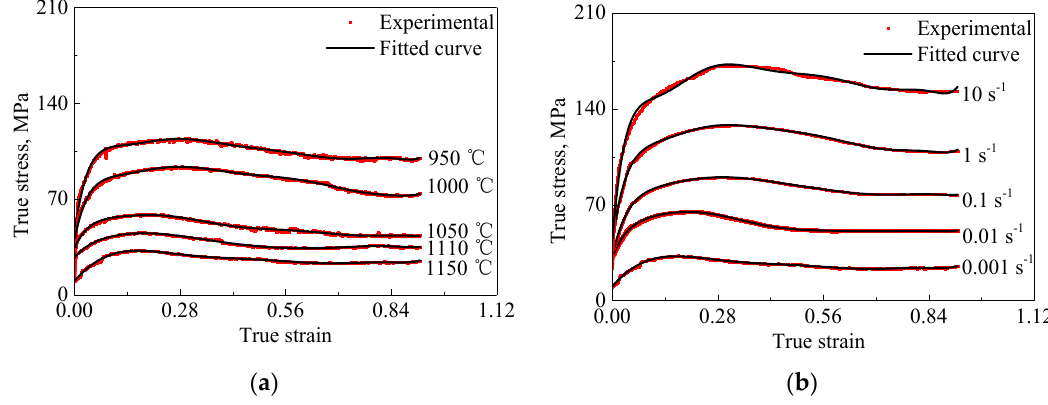
. ε = 0.001 s ´ 1 ; ( b ) T = 1150 ˝